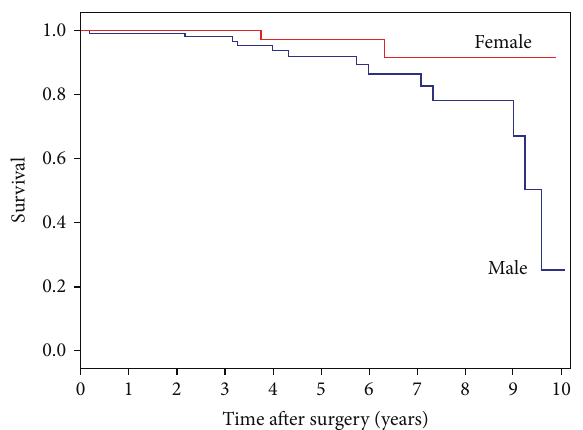
Figure 3: Kaplan-Meier survival curve for the studied